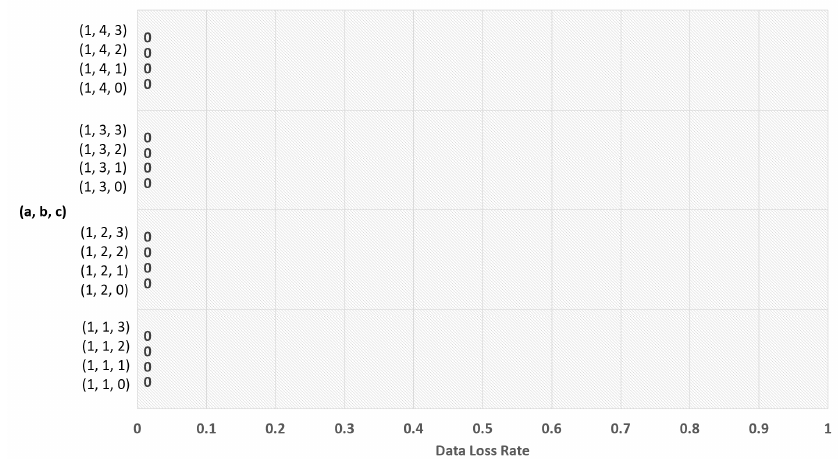
Figure 10. Data loss rate in case of using polynomial function with ‘a’ = 1.